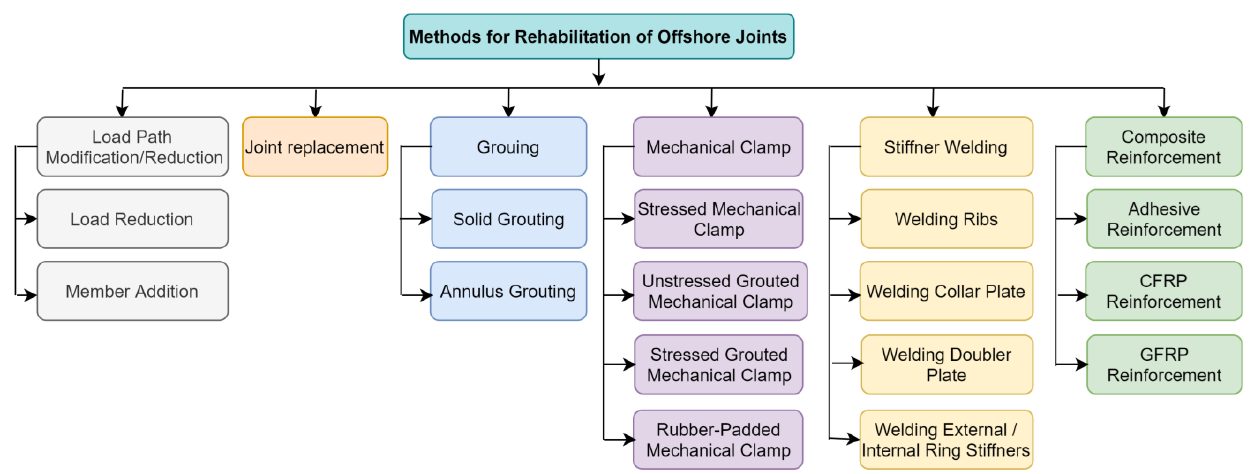
Figure 6. Techniques for offshore joint rehabilitation.